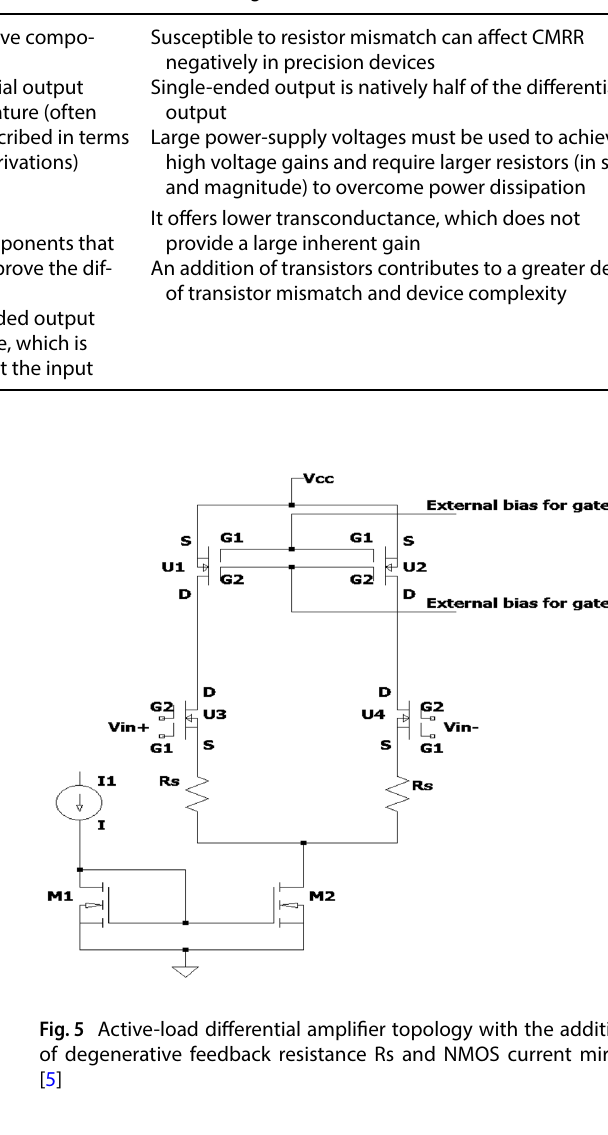
Table 1 Advantages and disadvantages of resistive-loaded and active-loaded differential amplifier topologies [4–6, 8, 13, 14, 19, 26–28] Advantages